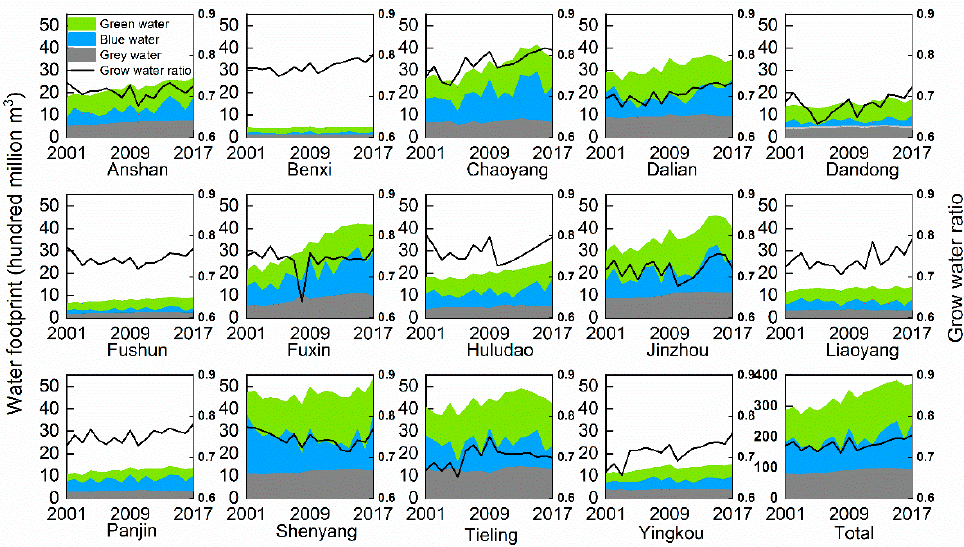
Figure 2. The trend of crop water footprint every city in Liaoning Province. Table 1. The variation coefficient and M-K test of crop water footprint of every city in Liaoning Province.